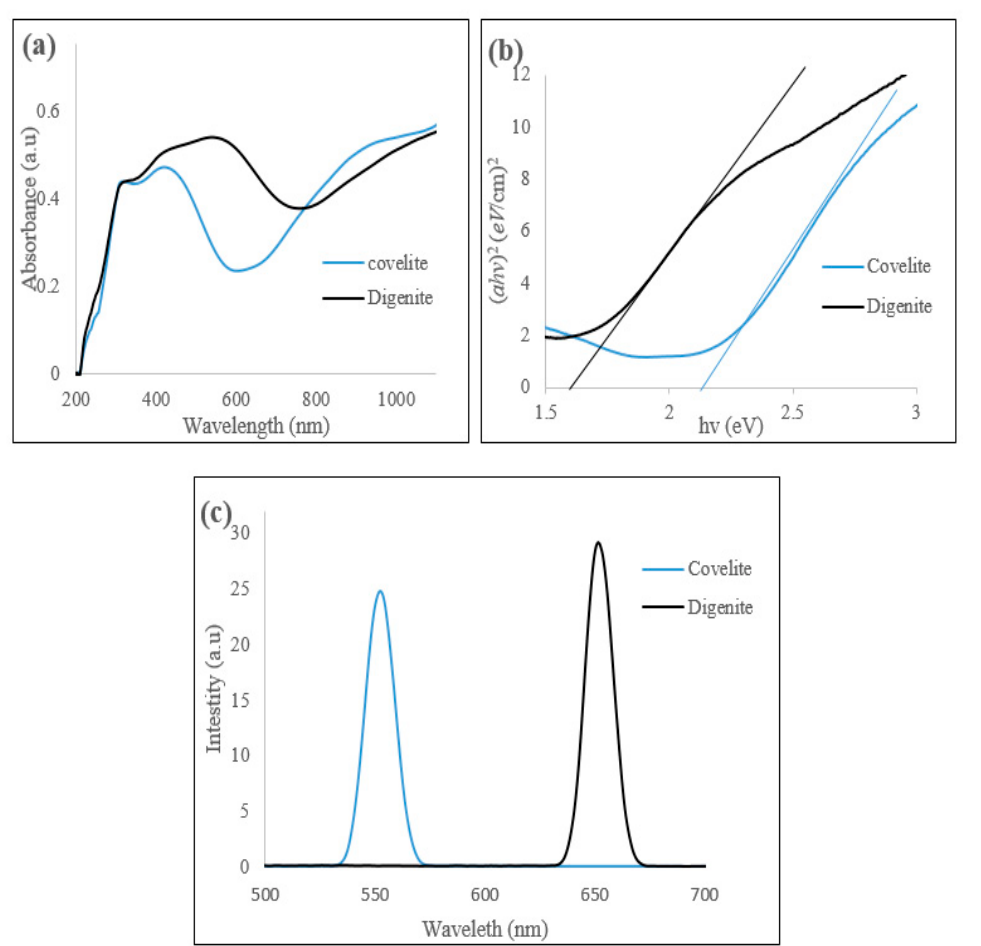
Figure 4. ( a ) UV–vis–NIR spectra of covellite (CuS) and ( b ) digenite (Cu 9 S5); ( c ) their photoluminescence spectra.